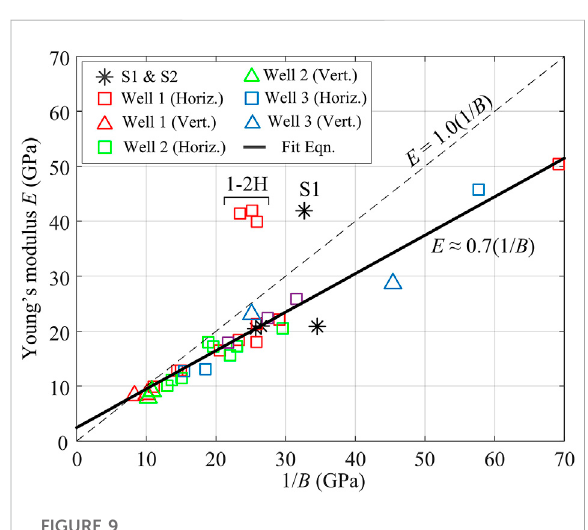
FIGURE 9 Relationship of 1/ B and Young ’ s modulus derived from the multi-step creep